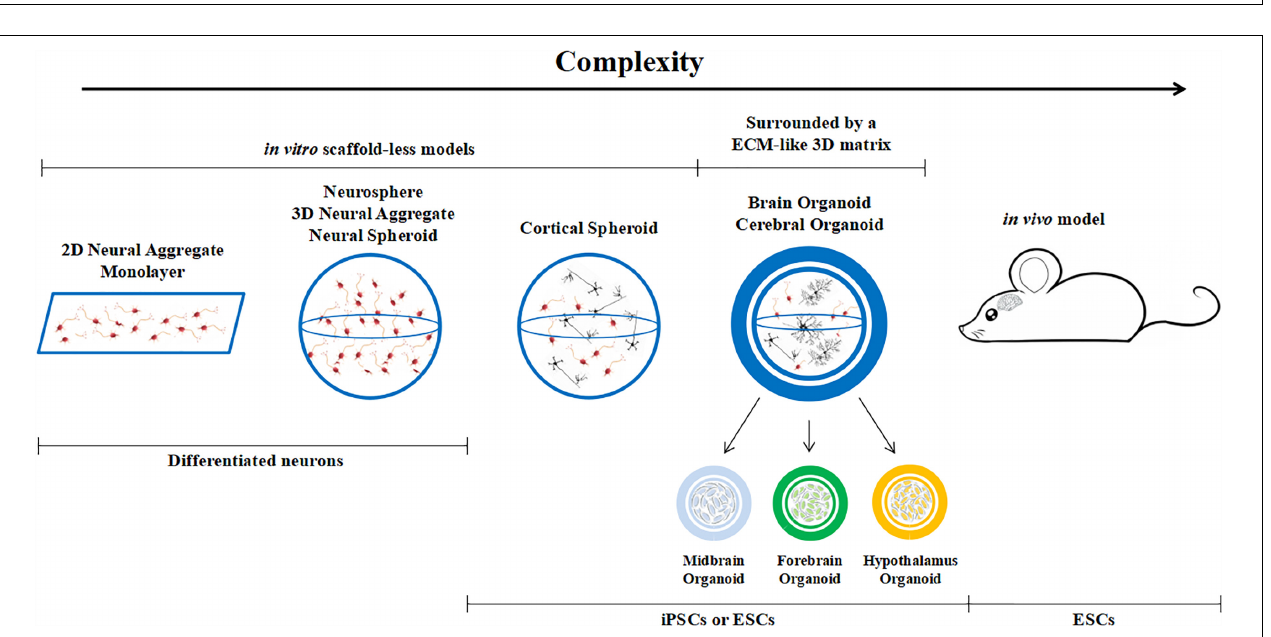
FIGURE 2 | Classification of brain models, from monolayers to in vivo animal models.